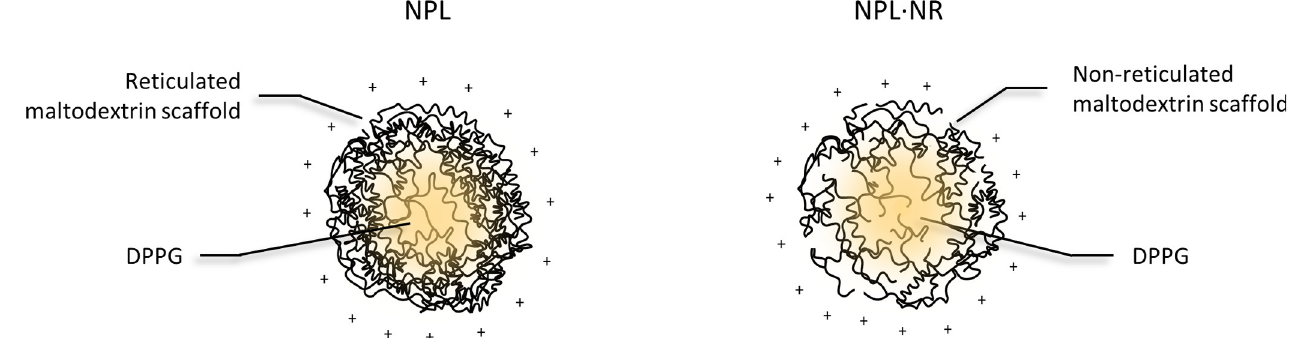
Fig 1. Schematic representation of NPL (cationic particles with reticulated maltodextrin and a DPPG phospholipid core) and NPL � NR (cationic particles with non-reticulated maltodextrin and a DPPG phospholipid core).